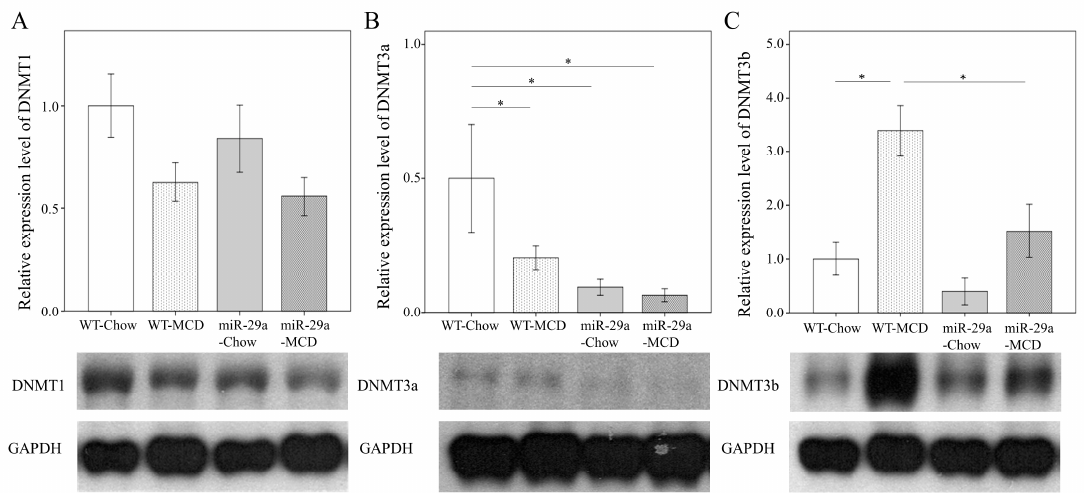
Figure 3. Overexpression of miR-29a reduced DNA methyltransferases in MCD diet mice. Comparison of the activation of DNA methyltransferase 1 ( A ), 3a ( B ), and 3b ( C ) in WT and miR-29Tg mice livers. Data from the six to eight samples per group are expressed as mean ± SD. * indicates a p < 0.05 between the groups.